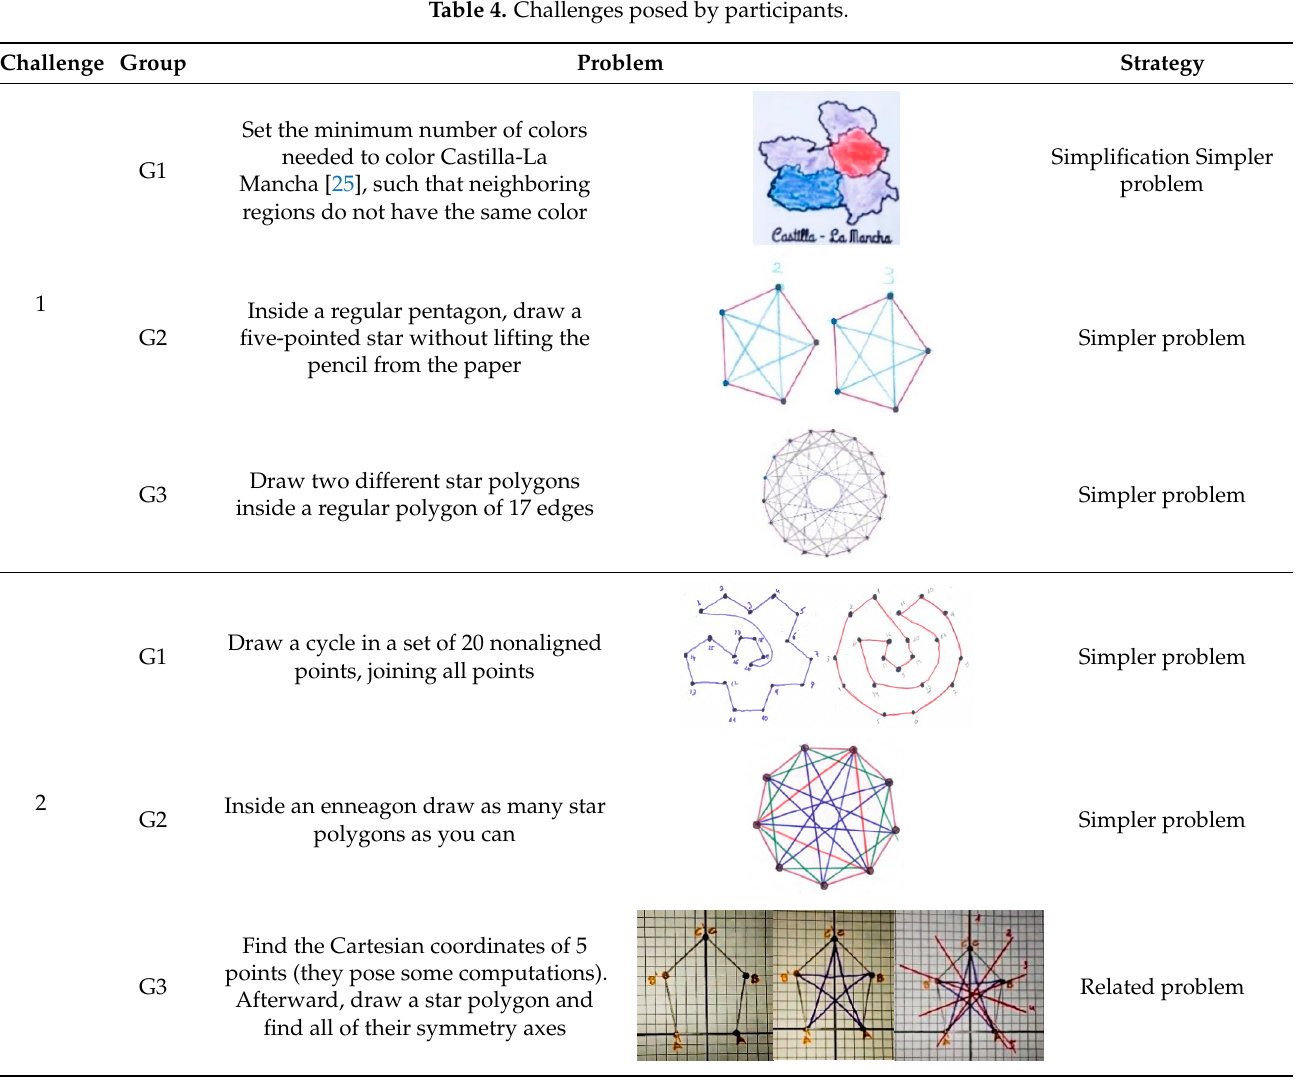
Figure 14. Chess routes. Drawing made by participant: ( a ) A5 using a rook; ( b ) A3 using a rook; ( c ) A7 using the queen; ( d ) A4 using a rook; ( e ) A6 using the king.